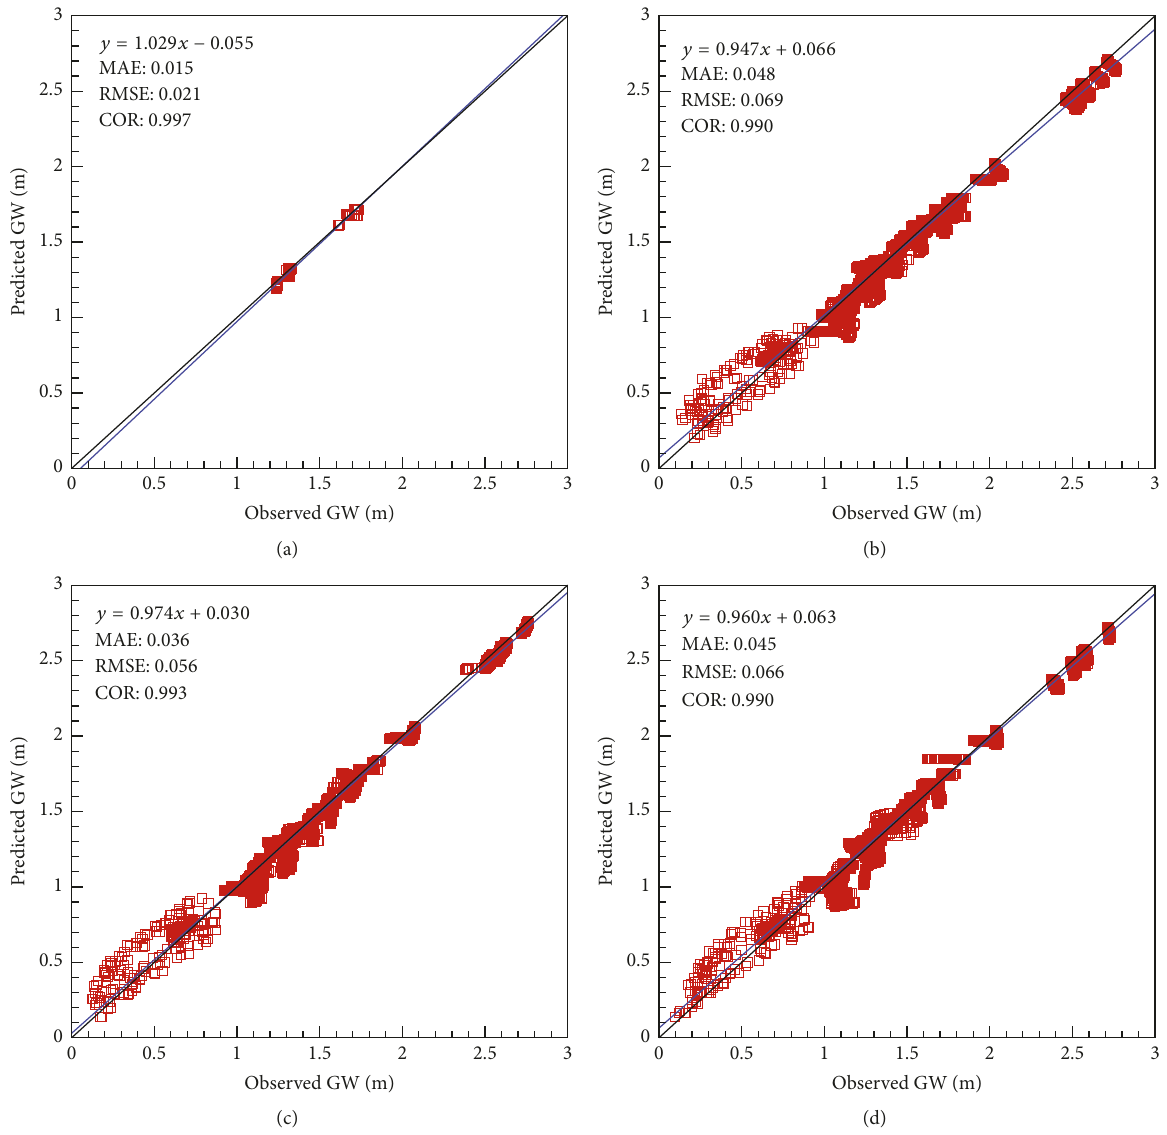
Figure 13: Scatter plots of the predicted groundwater levels of the optimal estimated heterogeneous 𝛼 field and the observed groundwater levels of the historical records in the real aquifer. (a) Groundwater level results of the 5 observation wells at 24 hr; (b) groundwater level results of the 55 observation wells at 72 hr (01/08/2014 ∼ 01/10/2014); (c) groundwater level results of the 55 observation wells at 72 hr (01/11/2014 ∼ 01/13/2014); and (d) groundwater level results of the 55 observation wells at 72 hr (01/14/2014 ∼ 01/16/2014).